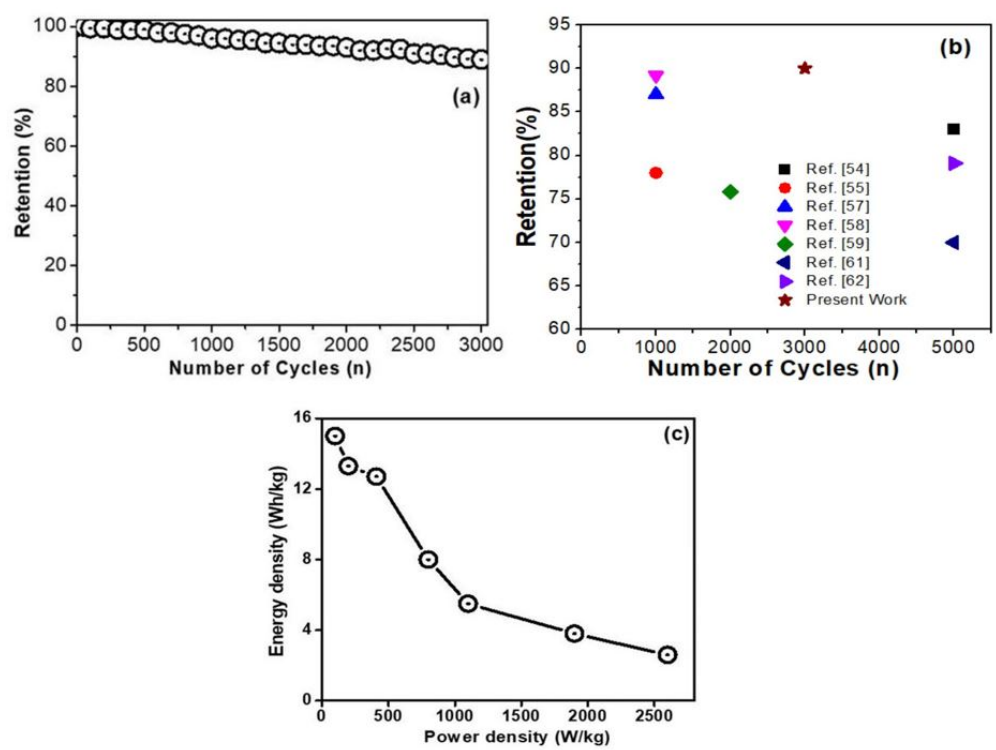
Figure 12. ( a ) Cycle stability of Ag-rGO@MnO 2 nanocomposite, ( b ) comparative cycle stability graph of MnO 2 -based nanocomposites in further published papers, and ( c ) Ragone plot of Ag-rGO@MnO 2 nanocomposite.